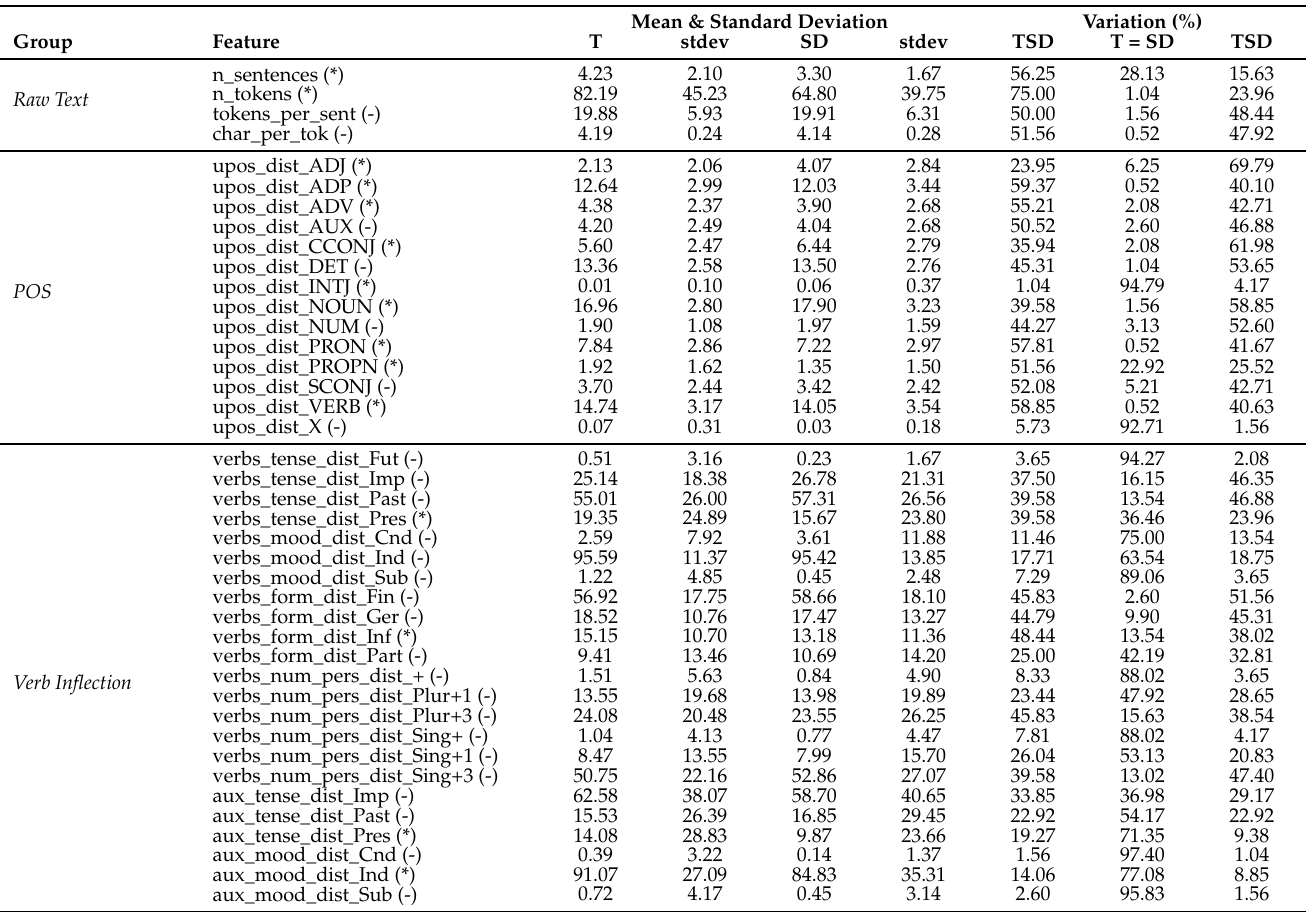
Table A2. Linguistic features acquired from transcriptions, organised by group: for each feature, we report their mean value and standard deviation in the two sub-corpora of Truthful (T) and Simulated Deception (SD) testimonies. In the “Variation” block, we report the percentage of testimonies